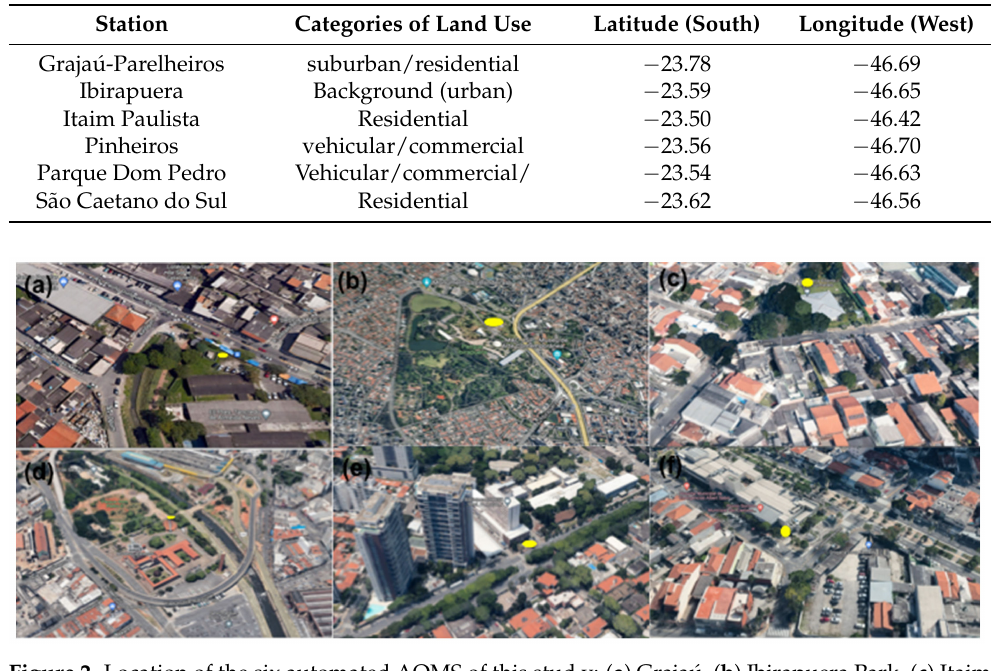
Figure 2. Location of the six automated AQMS of this stud y: ( a ) Graja ú , ( b ) Ibirapuera Park, ( c ) Itaim Paulista, ( d ) Parque Dom Pedro, ( e ) Pinheiros, and ( f ) S ã o Caetano do Sul. The monitoring points are indicated by yellow